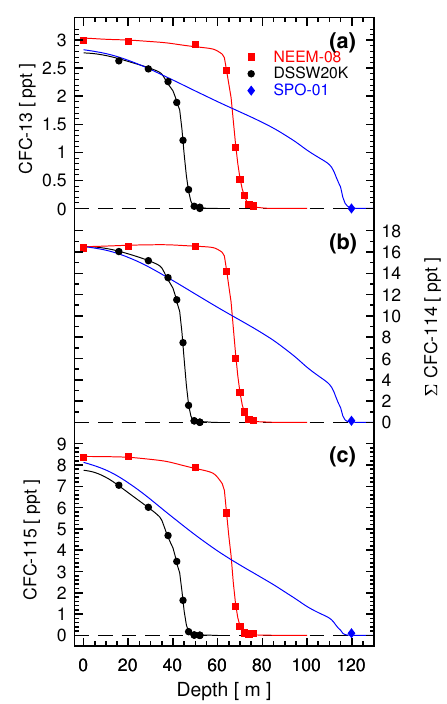
Figure 2. Depth profiles for the three chlorofluorocarbons CFC-13 (a) , (cid:54) CFC-114 (b) , and CFC-115 (c) in polar firn. Measured dry- air mole fractions are shown for the Greenland site NEEM-08 (red squares) and the Antarctic sites Law Dome (DSSW20K, black cir- cles) and South Pole (SPO-01, blue diamond). Generally the mea- surement precisions (1 σ ) are smaller than the plotting symbols. The modeled mole fraction depth profiles (solid lines) correspond to the optimized emission history from the CSIRO inversion, derived from the combined observations of all three firn sites, archived air, and in situ